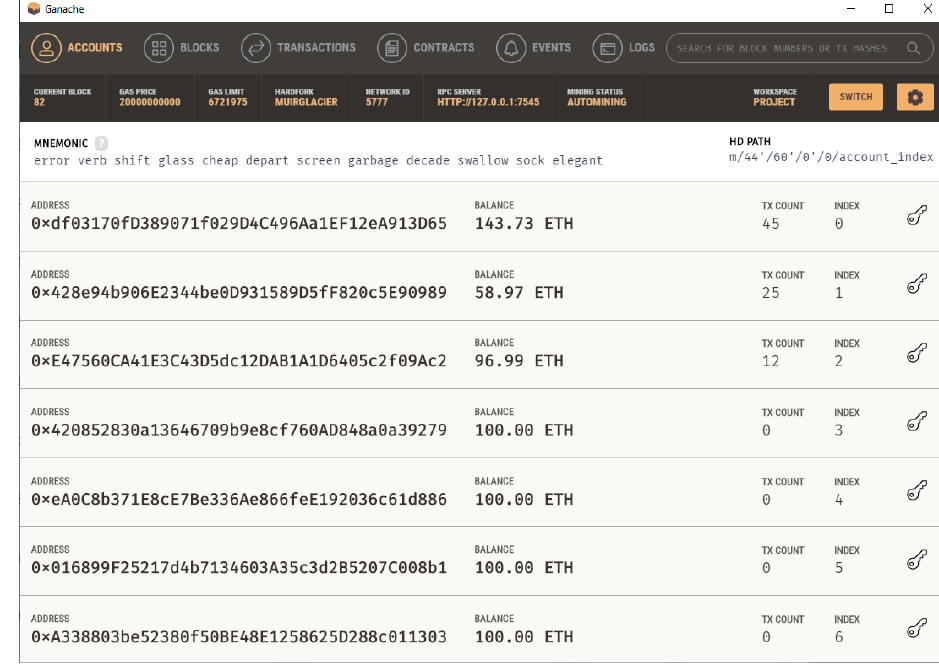
Figure 6. Ganache UI blockchain